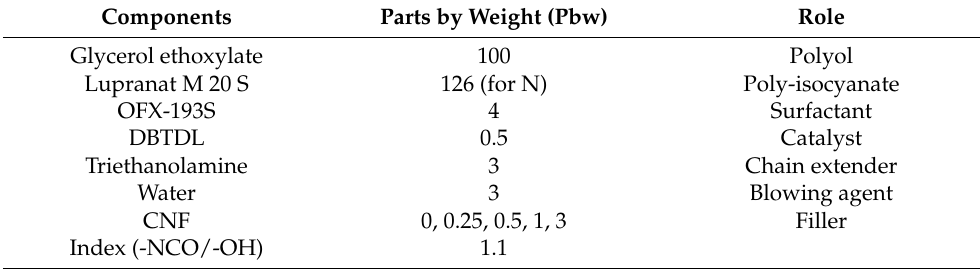
Table 1. The formulation of the PU foams. Components Parts by Weight (Pbw) Role Glycerol ethoxylate 100 Polyol Lupranat M 20 S 126 (for N) Poly-isocyanate OFX-193S 4 Surfactant DBTDL 0.5 Catalyst Triethanolamine 3 Chain extender Water 3 Blowing agent CNF 0, 0.25, 0.5, 1, 3